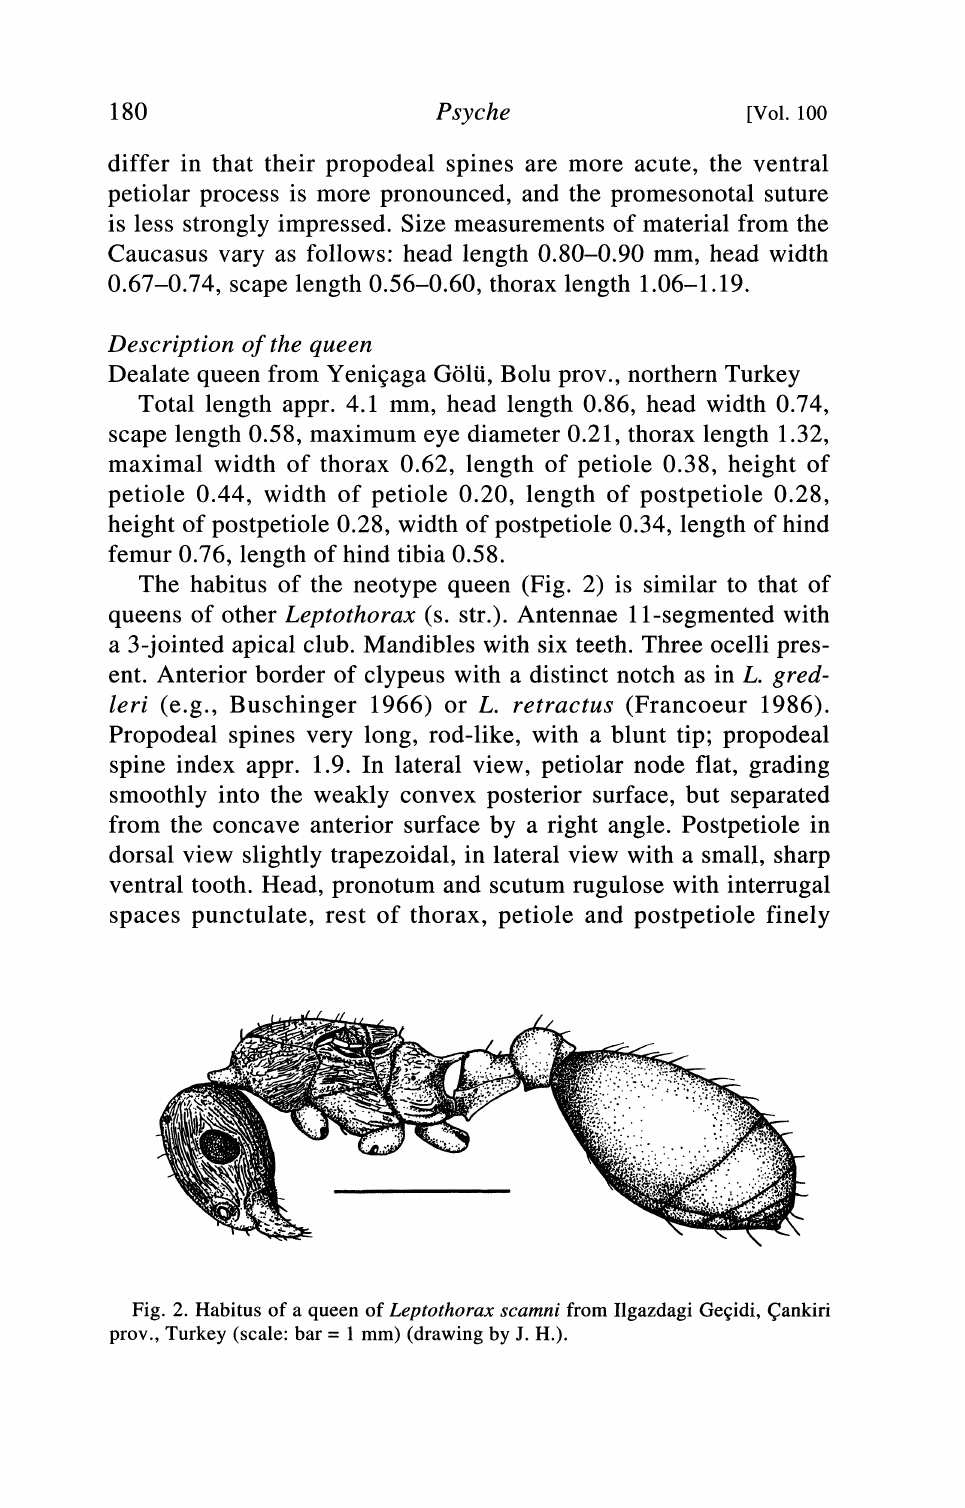
Fig. 2. Habitus of a queen of Leptothorax scamni from Ilgazdagi Geidi, ankiri prov., Turkey (scale: bar mm) (drawing by J.